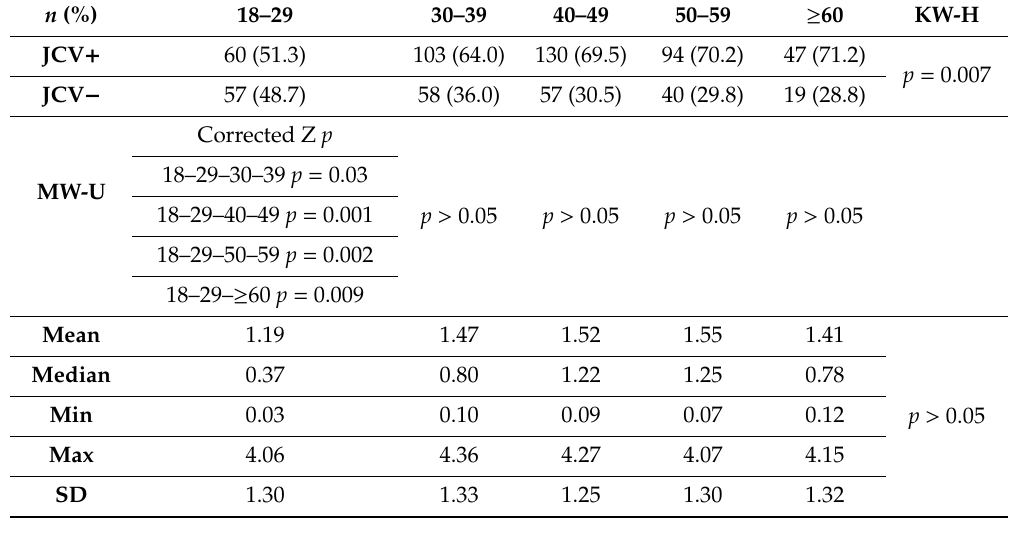
Table 4. Anti-JCV antibody prevalence and antibody index by the patients’ age (years).